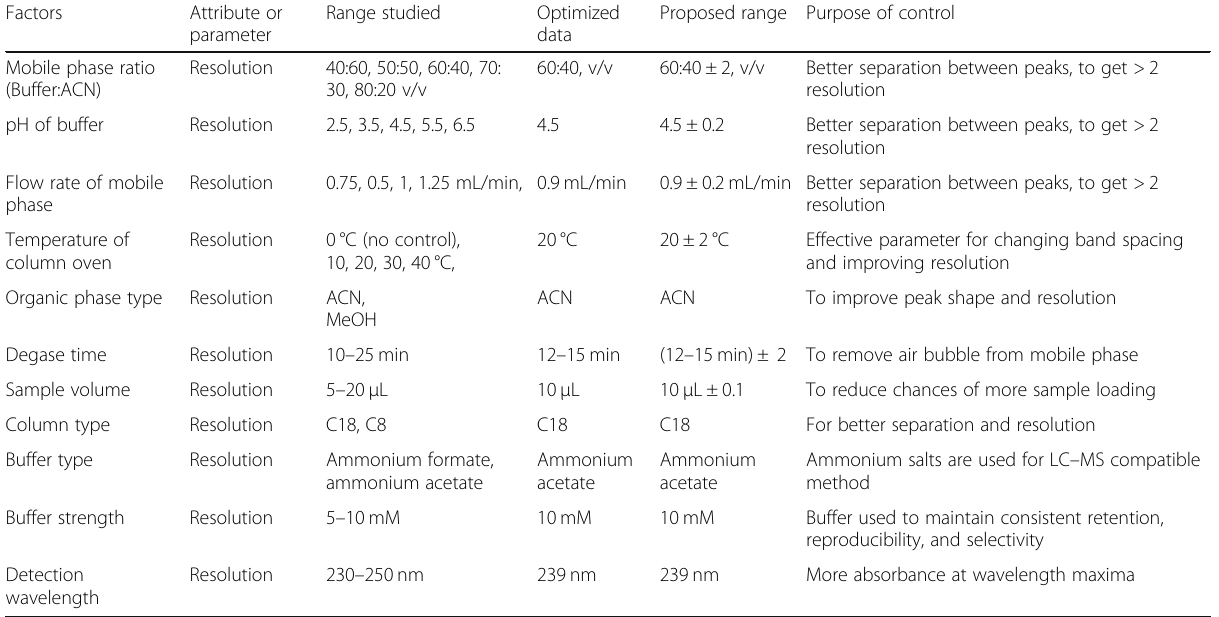
Table 3 Control strategy for stability methods of AV obtained by CCD